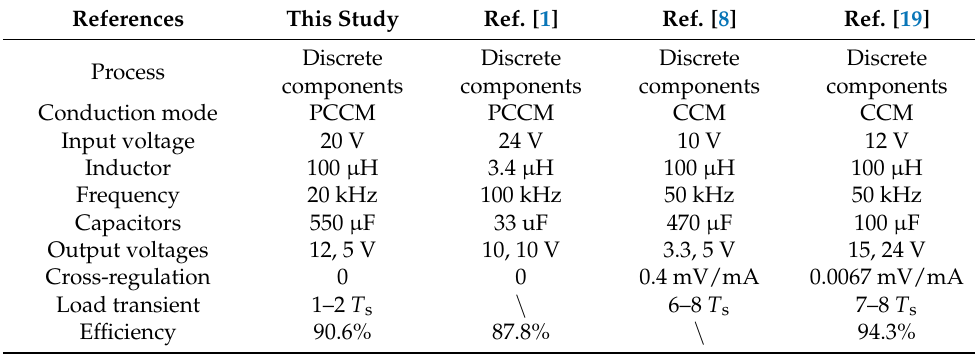
Table 2. Survey of the existing literature on PCCM SIDO DC – DC converters.